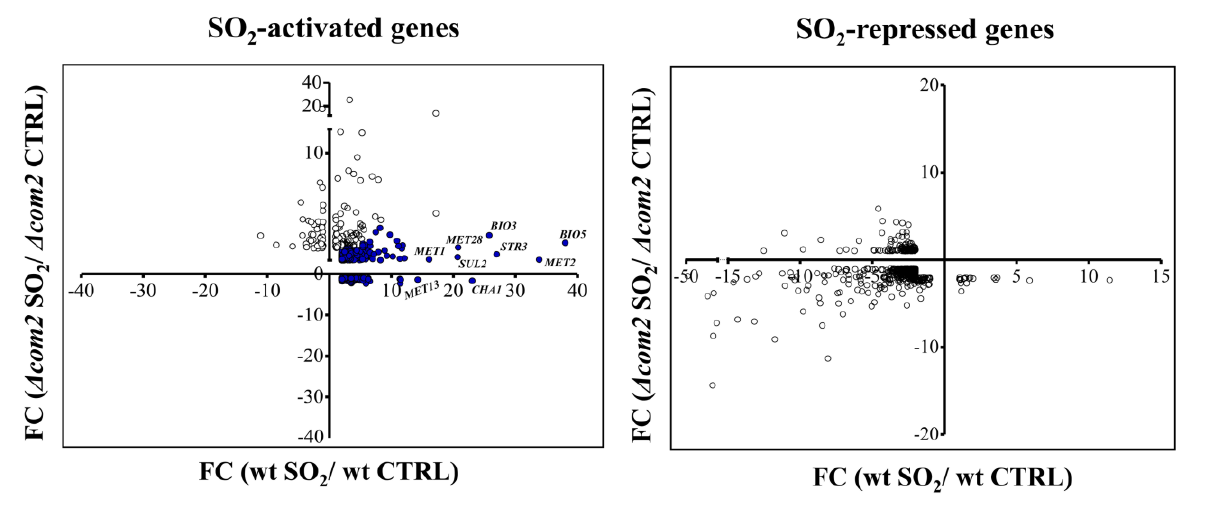
FIGURE 2: Overview on the transcriptomic profile of SO 2 - challenged BY4741 or Δcom2 cells. The genes whose transcription increased more than 2-fold in the presence of SO 2 , comparing with the levels attained in control conditions, were selected for this representation. Genes activated by SO 2 in wild-type cells but not in the mutant were considered as Com2-targets and are herein highlighted in